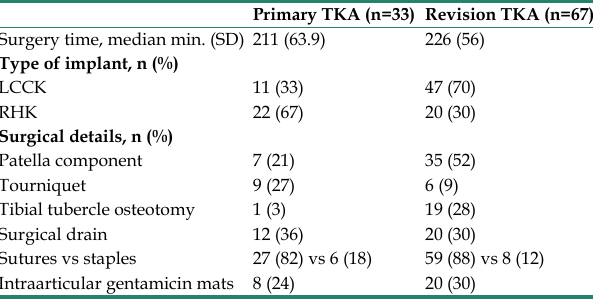
Table 2. Surgical